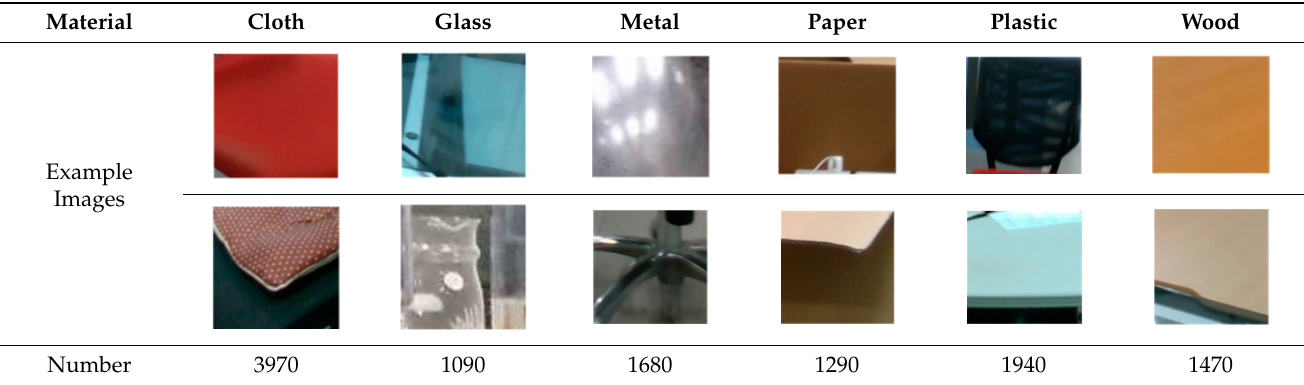
Table 3. Number of data acquired from actual usage environment.